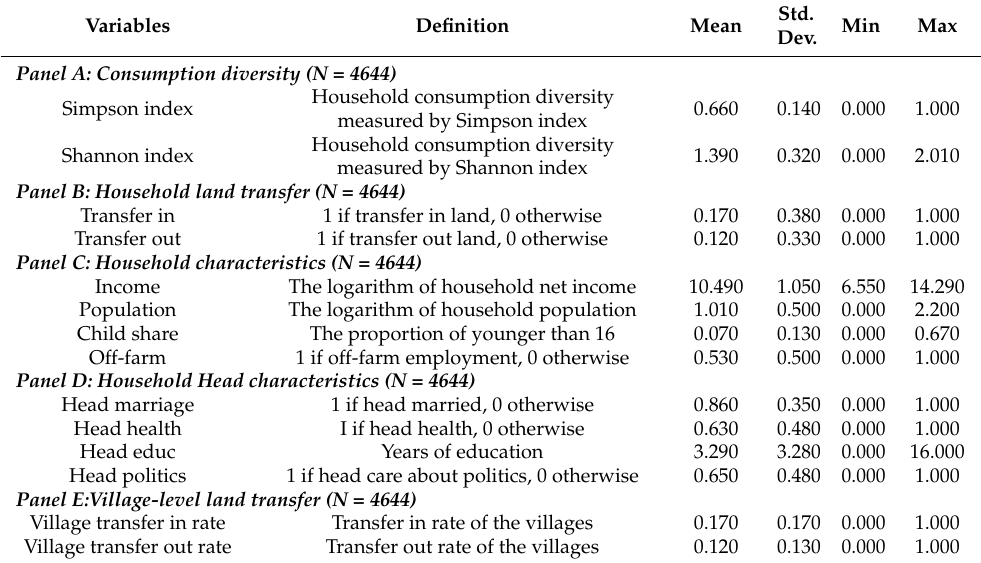
Table 1. Data definition and descriptive